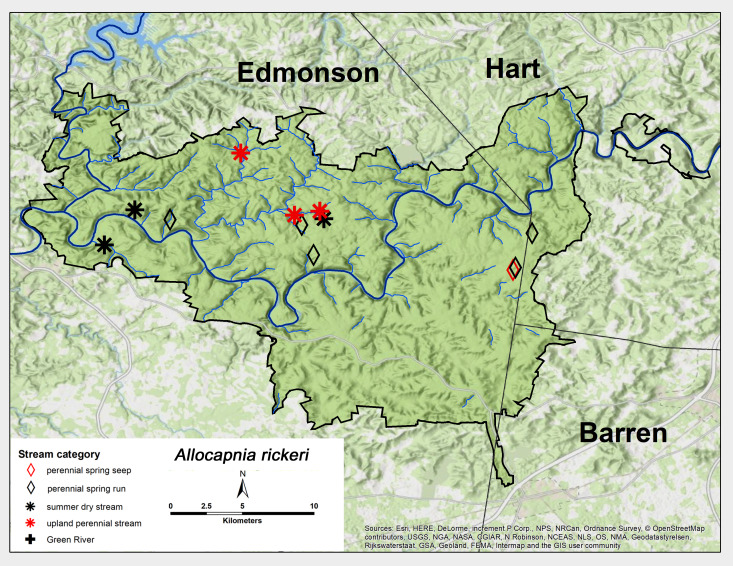

Allocapnia
rickeri